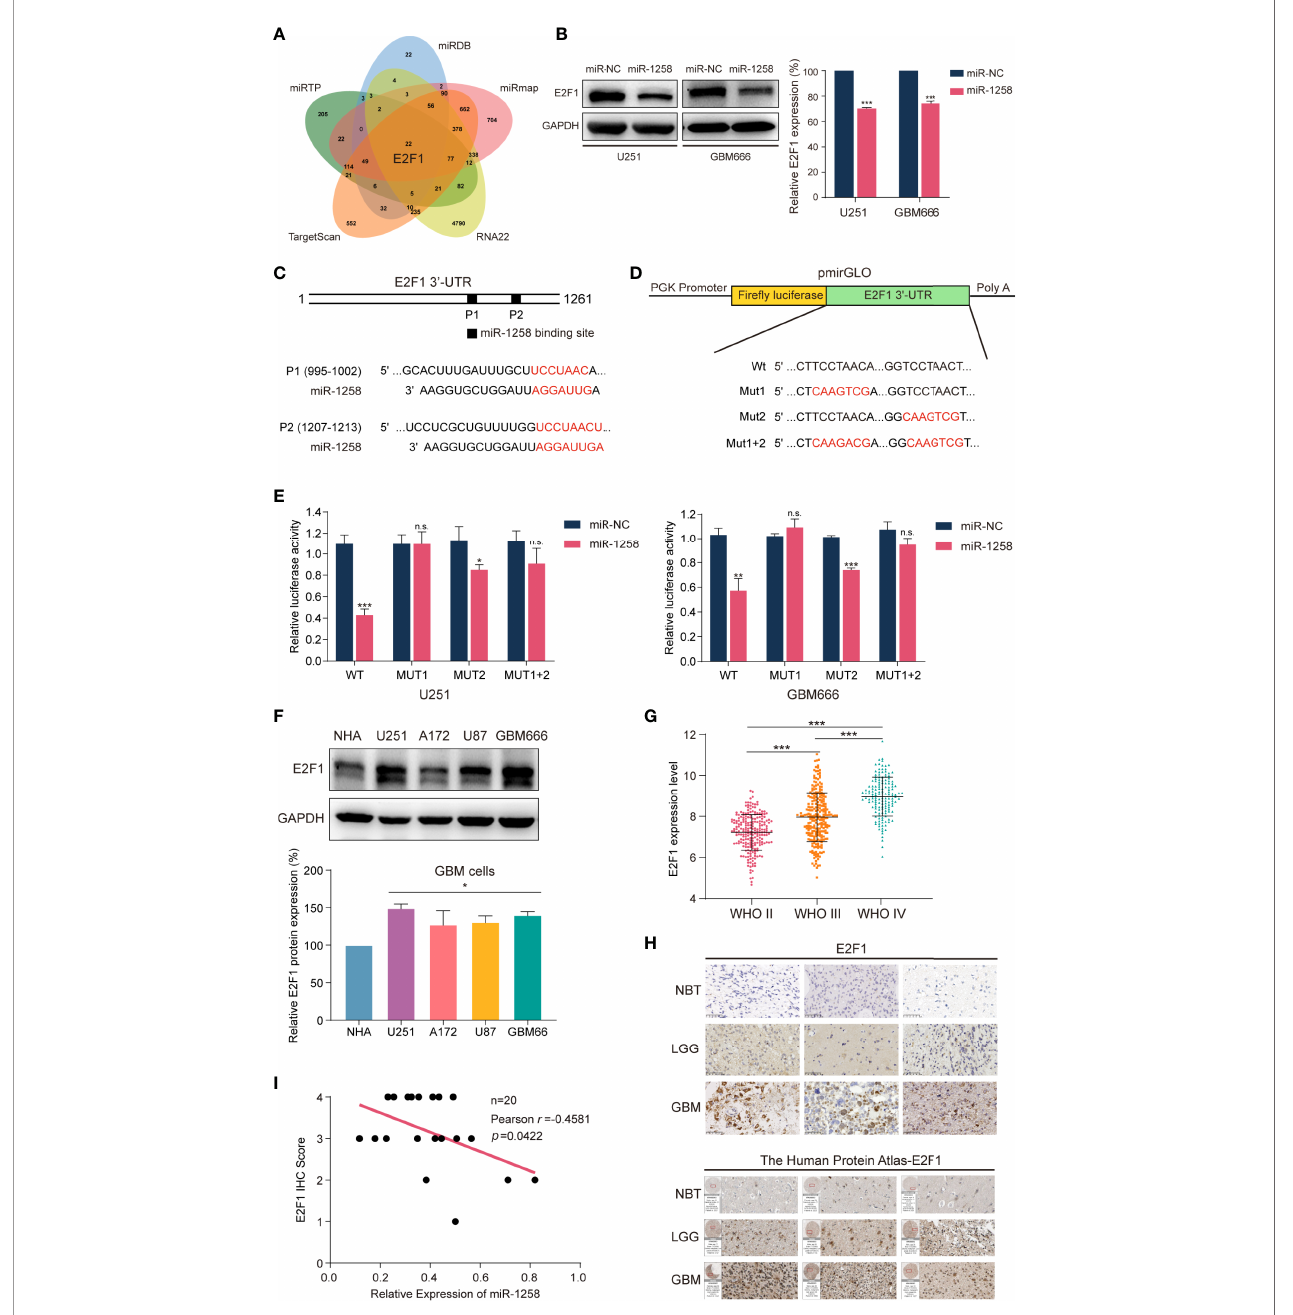
FIGURE 3 | miR-1258 directly targets E2F1 in 3 ’ -UTR and negatively regulates its expression. (A) The Venn diagram demonstrated that miR-1258 targeted E2F1 mRNA intersecting fi ve prediction databases: TargetScan, miRTP, miRDB, RNA22, and miRmap. (B) The decreased expressions of E2F1 protein were detected by western blot in U251 and GBM666 cells transfected with miR-1258; ***p < 0.001 when compared to miR-NC group. (C) Algorithms predicted two miR-1258 target sequences in the E2F1 mRNA 3 ’ -UTR. (D) The schematic diagram illustrated the construction of WT and Mut 3 ’ -UTR sequences in pmirGLO Dual-Luciferase miRNA target expression vector. (E) Dual-Luciferase reporter assays were used to assess GBM cells transfected with luciferase vectors carrying WT or Mut 3 ’ -UTR of E2F1 , in response to miR-1258 or miR-NC; *p < 0.05, **p < 0.01, ***p < 0.001, n.s., no signi fi cance between miR-1258 and miR-NC group. (F) E2F1 expressions were detected by western blot in normal human astrocytes (NHA), three GBM cell lines (U251, A172, U87), and GBM666 primary GBM cells; *p < 0.05 when compared to NHA. (G) Relative expression data of E2F1 in 226 WHO II cases, 244 WHO III cases, and 150 WHO IV cases were analyzed using the TCGA database; ***p < 0.001 between indicated groups. (H) E2F1 protein expressions were determined by immunohistochemistry in NBT, LGG and GBM samples; Scale bar = 50 m m. The expressions of E2F1 were also analyzed using the Human Protein Atlas database. (I) The correlations between E2F1 protein expression levels and relative miR-1258 expression levels in 20 GBM samples were analyzed by Pearson ’ s correlation analysis; r = -0.4581, p =